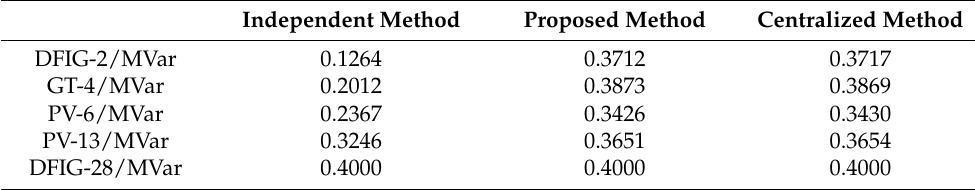
Table 6. Reactive power output of DGs in D26 with different methods on test case 1.